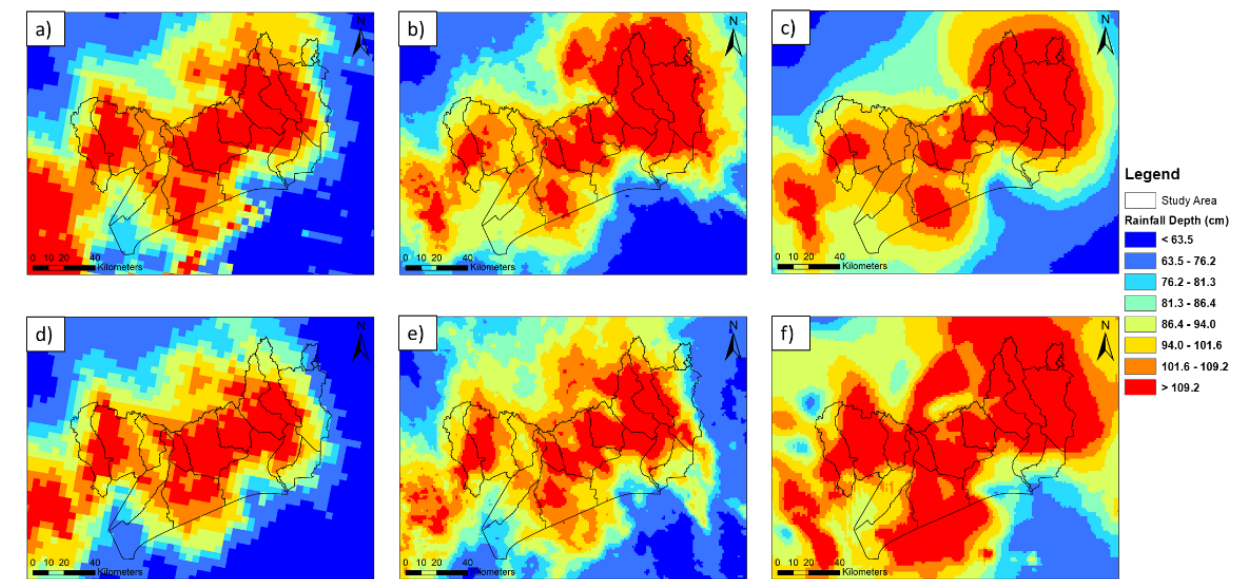
Figure 6. Precipitation maps from merged radar-gauge data of ( a ) Stage IV, ( b ) MRMS, ( c ) RTMA using BRK method, ( d ) Stage IV, ( e ) MRMS, ( f ) RTMA using RK method during Hurricane Harvey.